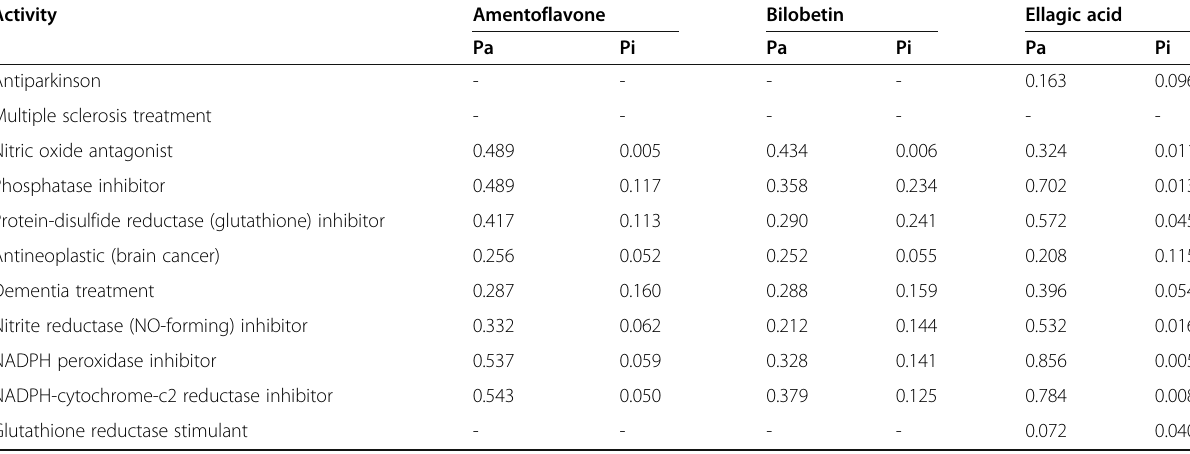
Table 6 Result of pharmacological activity prediction of selected ligand molecules. Pa>0.7: Compound is very likely to have activity; Pa>0.5: Compound is likely to have activity; Pa>0.3: Compound is less likely to have